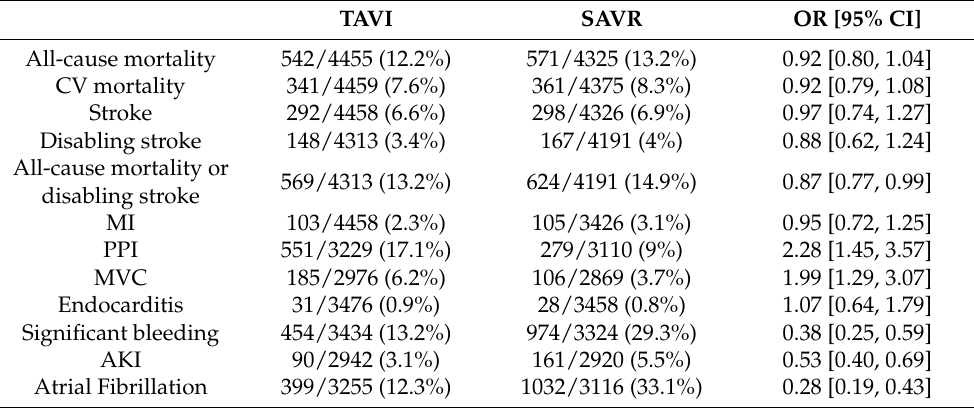
Figure 4. Forest plot for permanent pacemaker implantation ( A ), major vascular complication ( B ), myocardial infarction ( C ), significant bleeding ( D ), acute kidney injury ( E ), atrial fibrillation ( F ). Table 2. Summary of main